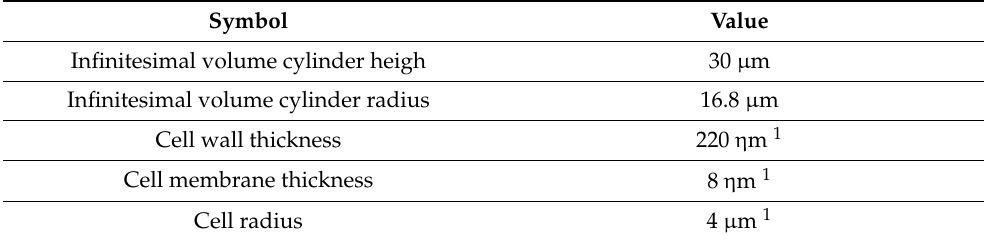
Table 1. Geometric simulation parameters. Symbol